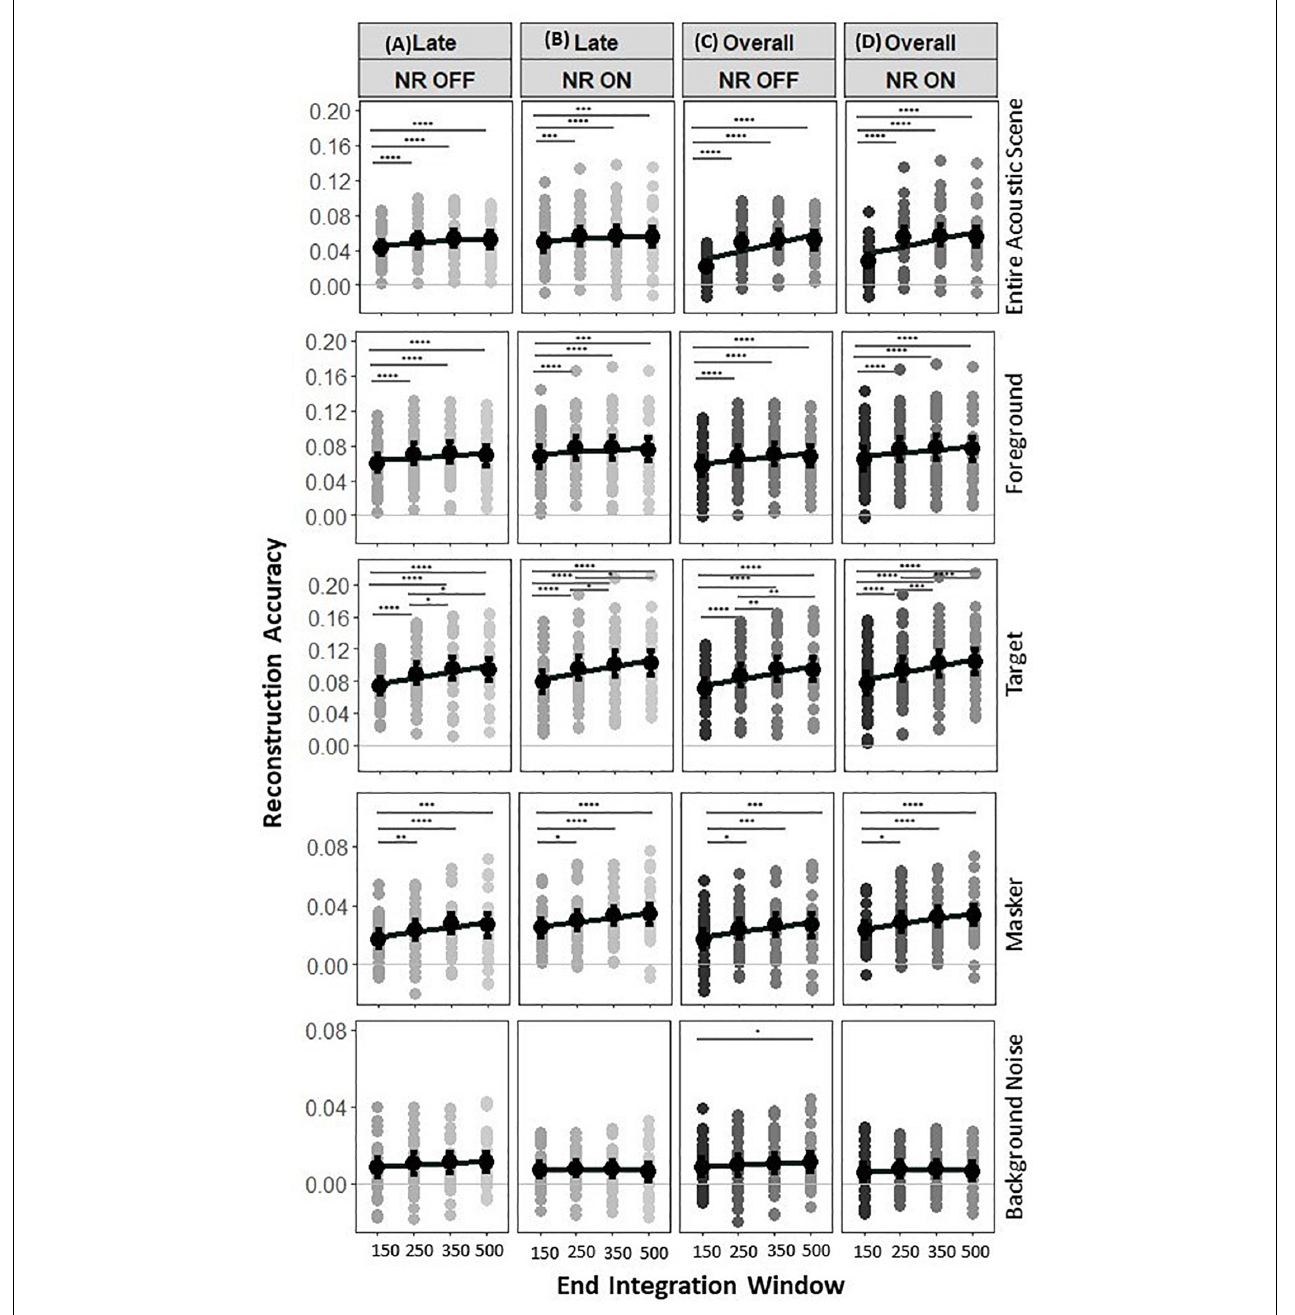
FIGURE 7 | Reconstruction accuracy for late vs. overall EEG responses. Reconstruction accuracy in two experimental conditions (“NR OFF” and “NR ON”) tested for the four late integration windows tested for late responses only [left, (A,B) ] and overall responses [(right, (C,D) ]. No significant differences were found between reconstruction accuracy in the acoustic scene, foreground, target, masker and background noise envelopes from late and overall EEG responses (i.e., the envelopes of the acoustic scene, foreground, target, masker, and background noise can be reconstructed with similar accuracy from late EEG responses only compared to from the overall EEG responses). The NR and sizes of the late and overall integration windows have significant effects on reconstruction accuracy for the acoustic scene, foreground, target, and masker envelopes, with strong reconstruction accuracy values seen up to 350 ms for the target envelope and 250 ms for acoustic scene, foreground, and masker envelopes. The NR, but not the sizes of the late and overall integration windows showed significant effect on the reconstruction accuracy for the background noise. Each row of panels shows results for a different envelope type, i.e., entire acoustic scene envelope, foreground envelope, target envelope, masker envelope, and background noise envelope. Gray dots indicate trial-averaged individual reconstruction accuracy results, whereas black dots and error bars show the group (grand-average ± 1 between subject SEM) reconstruction accuracy results using decoders trained only on the relevant envelope. The asterisk indicates significant differences (* p = 0.05, ** p = 0.01, *** p = 0.005, and **** p =